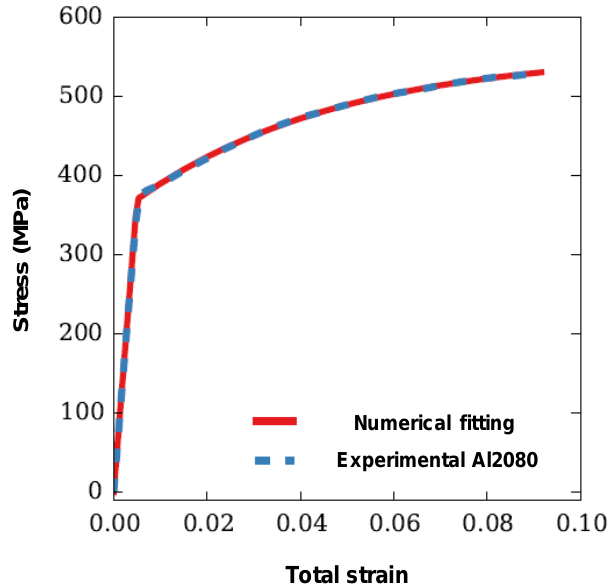
Figure 2. Comparison between the simulated and experimental stress-strain curves of 2080-T6 aluminum alloy.